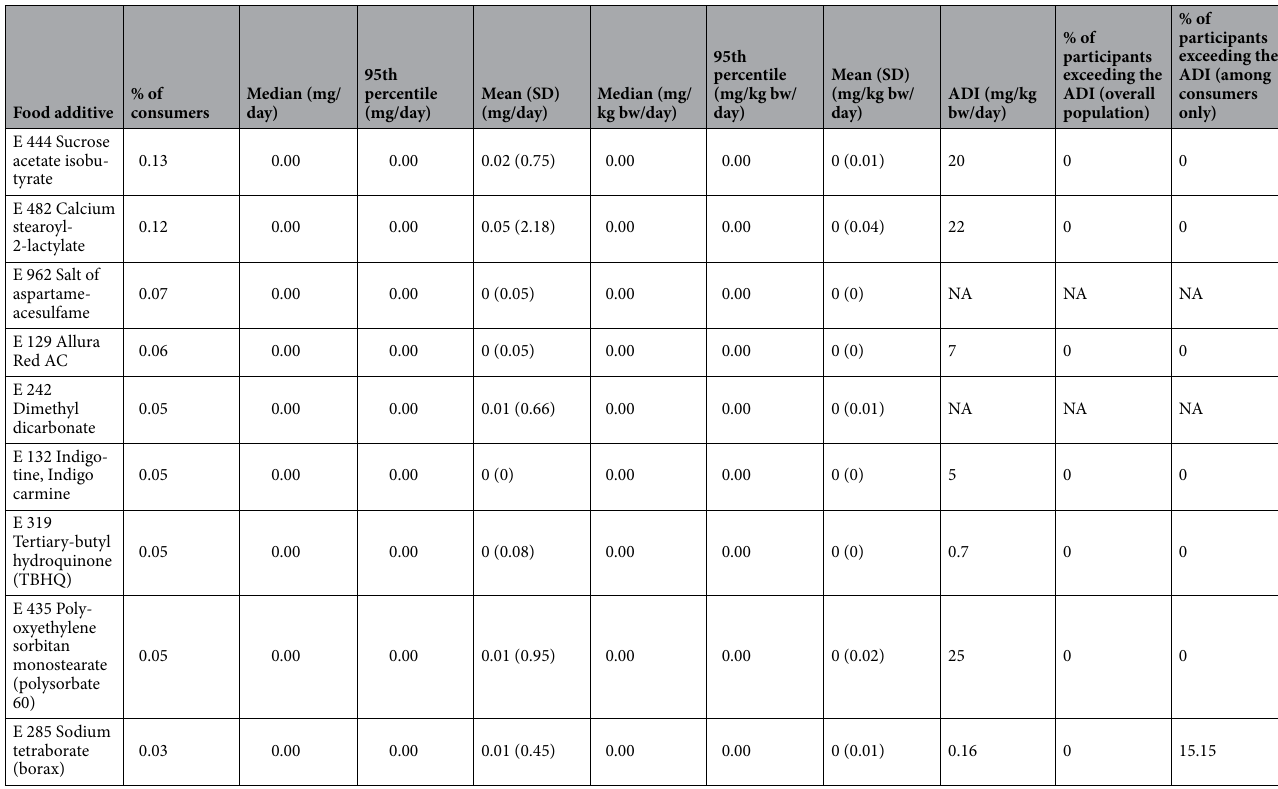
Table 1. Description of intakes of the 90 selected food additives, NutriNet-Santé cohort, France 2009–2020 (N = 106,489). Weighted according to the French national census report data by using the CALMAR macro run by sex and based on age, socio-professional category and housing